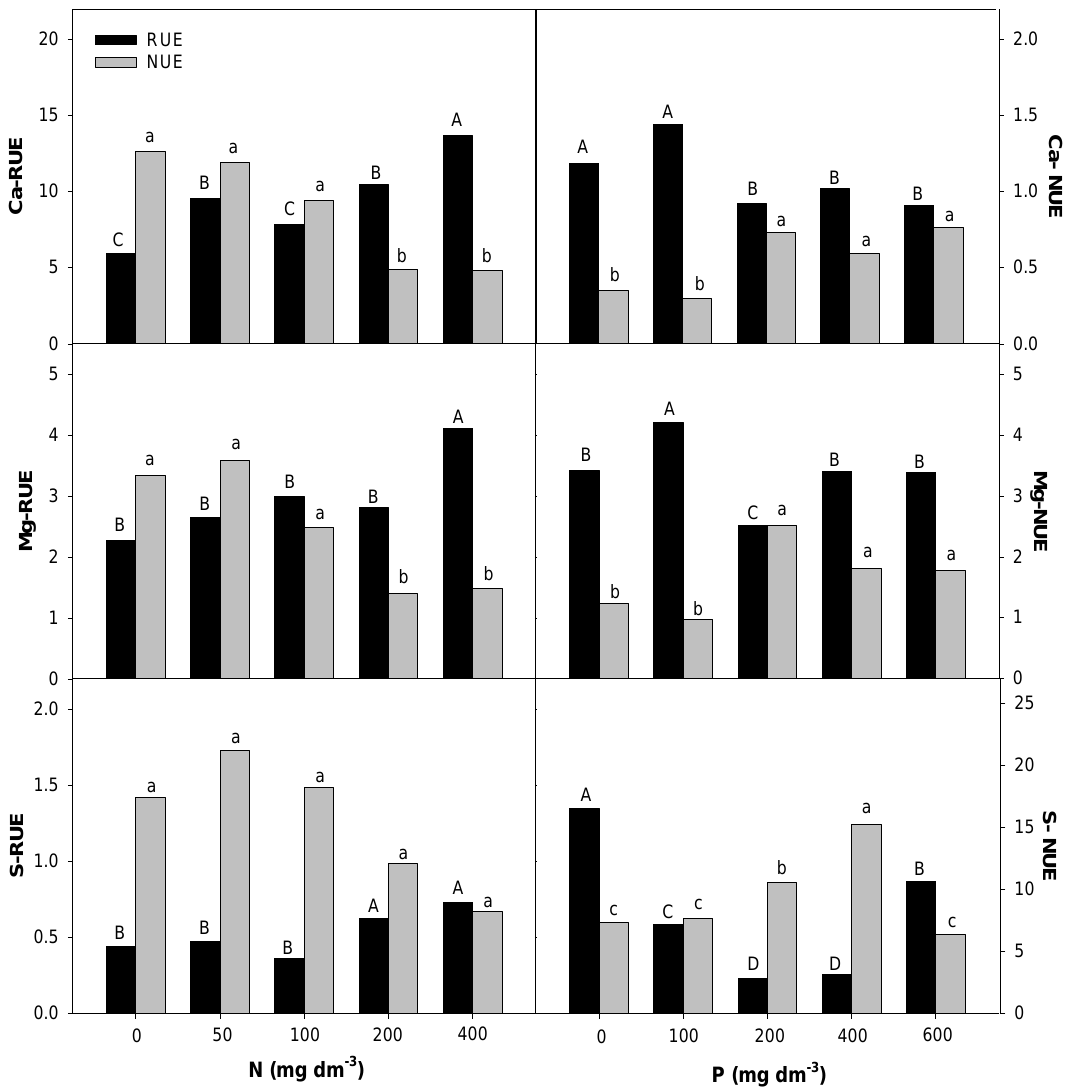
Figure 6. Root uptake efficiency (RUE) and nutrient use efficiency (NUE) for calcium (Ca), magnesium (Mg), and sulfur (S) in E. dysenterica seedlings. Root uptake efficiency (RUE, mg g⁻ 1 ) and plant nutrient use efficiency (NUE, g 2 mg⁻ 1 ) for the macronutrients Ca, Mg, and S in Eugenia dysenterica DC seedlings grown at varying rates of nitrogen and phosphorus for 278 d. Bars represent means ( n = 4). Means followed by the same letters, uppercase for RUE and lowercase for NUE, do not differ by the Scott-Knott clustering test ( p > 0.05).